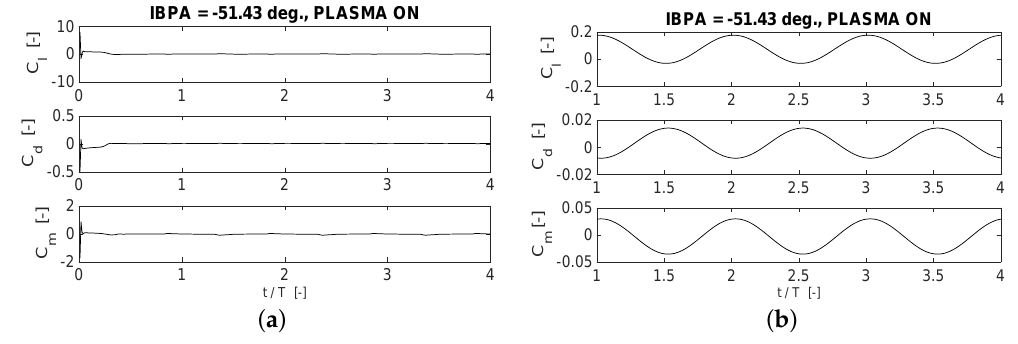
Figure 12. Time history of lift, drag and moment coefficient for the complete simulation ( a ) and for the last three periods ( b ); Re ∼ 195,000; IBPA = − 51.43 deg.; α = 2 + sin2 π f t + 4 × IBPA π /180 deg.; f = 19.17 Hz, T = 1/f.